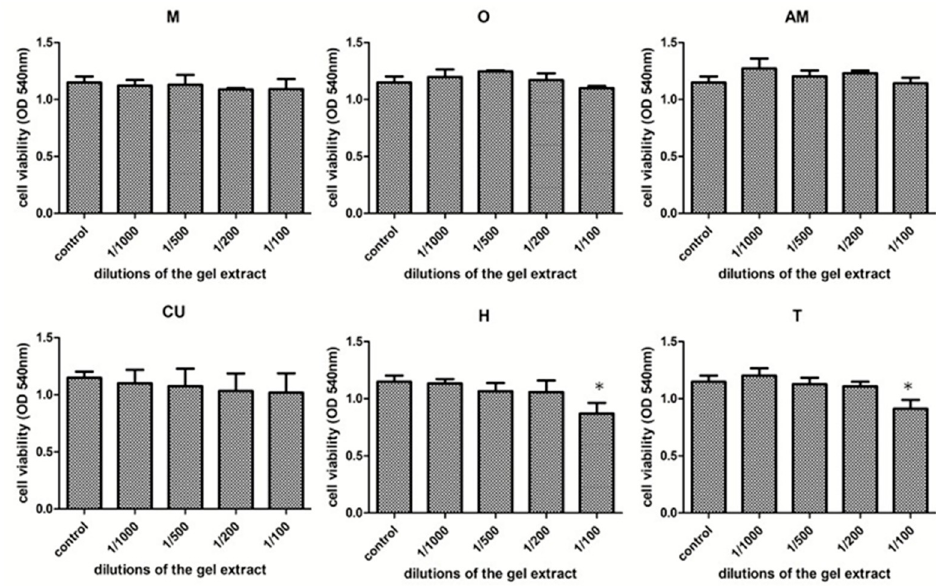
Figure 4. Cytotoxicity assay of the tested photosensitizers in different gel extract concentrations—0.001, 0.002, 0.005, 0.01; control PS (M), O with oregano essential oil, AM with Methylene Blue, CU with curcuma extract, H with Thieves mix essential oil, T with frankincense essential oil; Each bar represents mean ± standard deviation (n = 3), * represents p < 0.05, compared to untreated control.